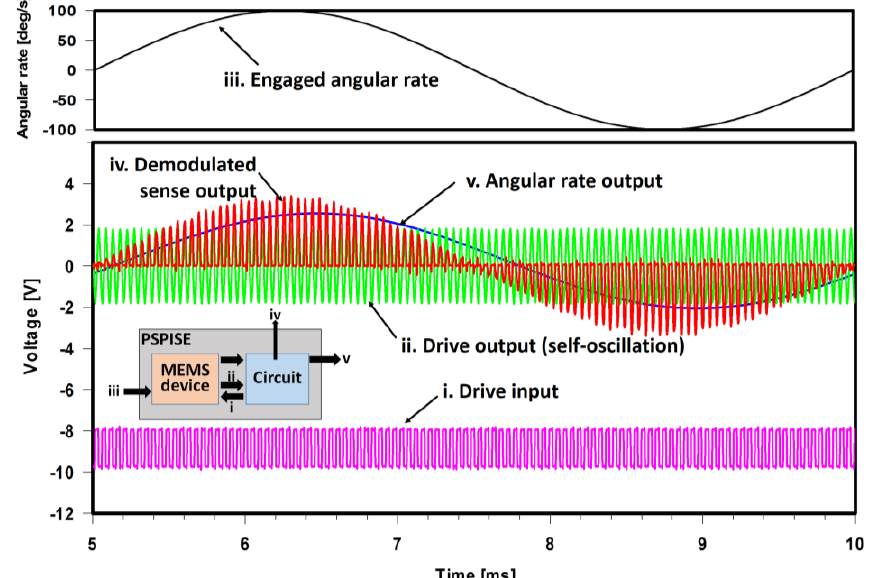
Figure 5. Signals from the combined simulation of the gyroscope and its driving and sensing circuit. (i) Drive input: the signal generated from circuit and applied on electrodes at MEMS device for oscillation. (ii) Drive output: the oscillation signal detected by electrodes at MEMS device followed by an amplification. (iii) The rotation engaged to the gyroscope. (iv) The demodulated sensing signal containing the applied angular rate. (v) The extracted angular rate output.